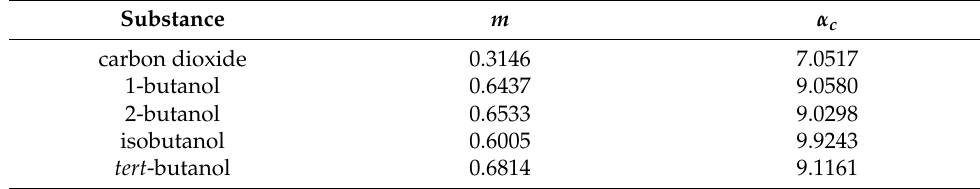
Table 8. GEOS parameters ( α c , m ) for pure components.